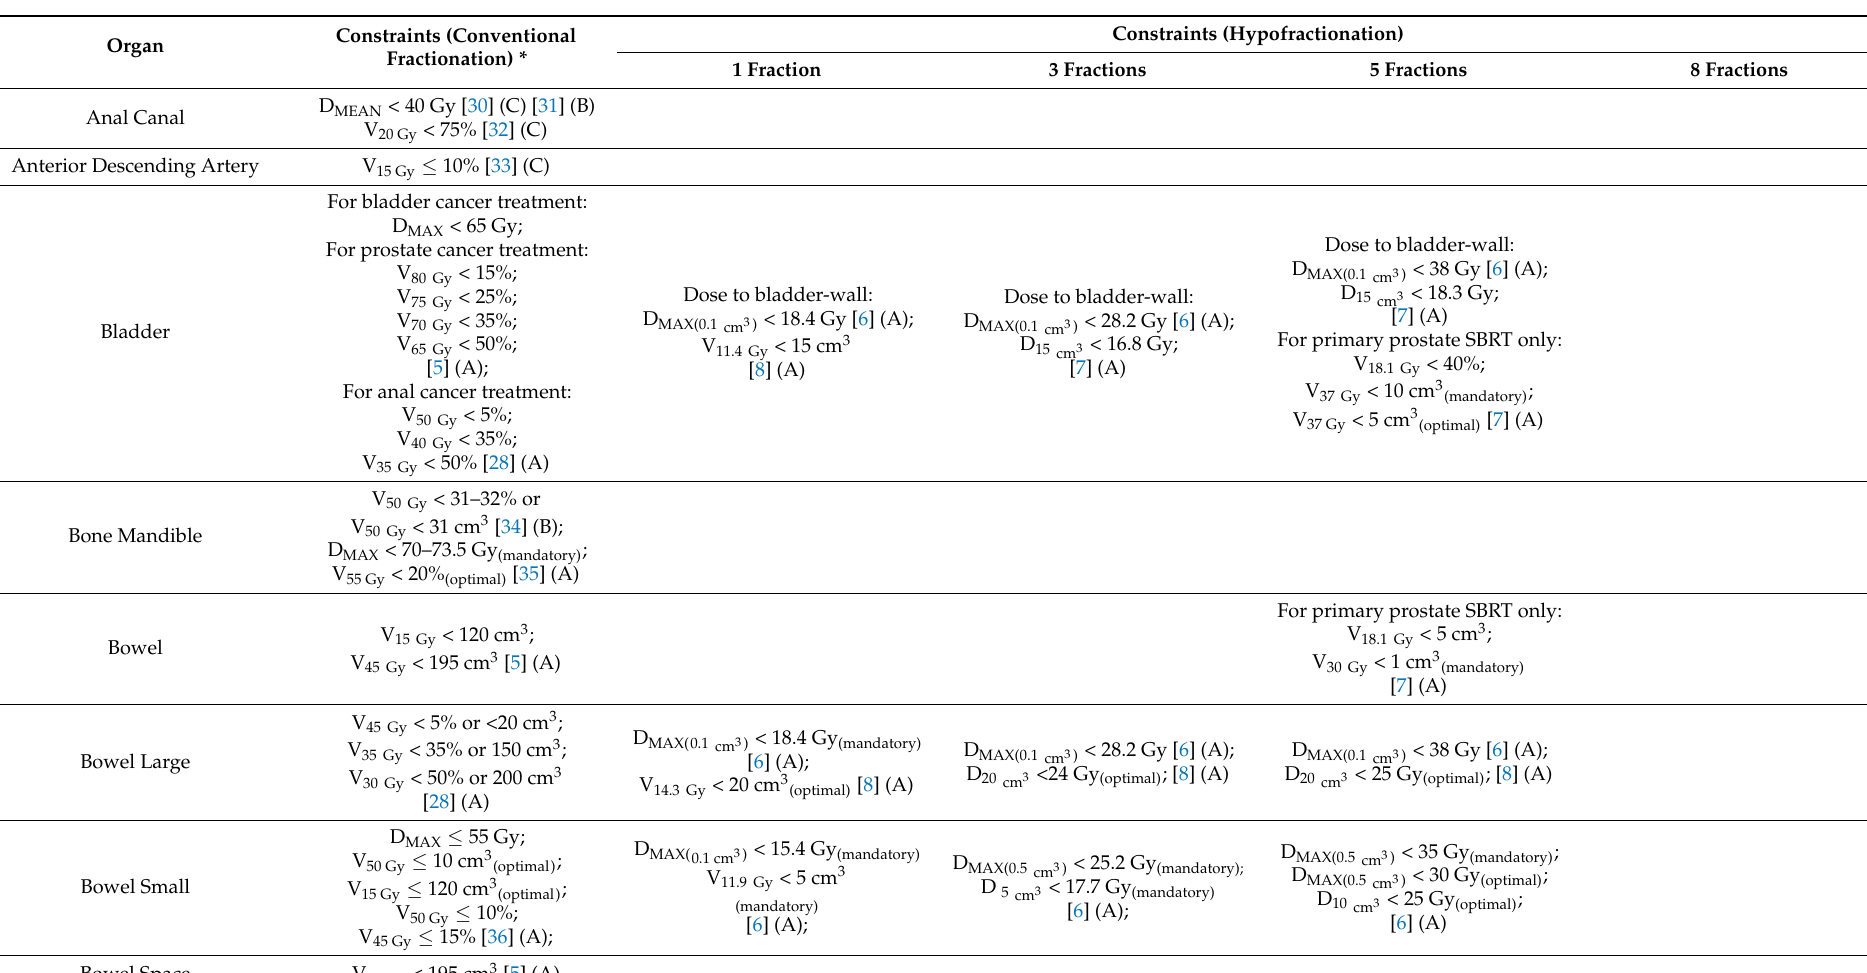
Table 1. General dose–volume constraints for adult patients (organ nomenclature based on the Global Quality Assurance of Radiation Therapy Clinical Trials Harmonization Group (GHG) contouring guidelines